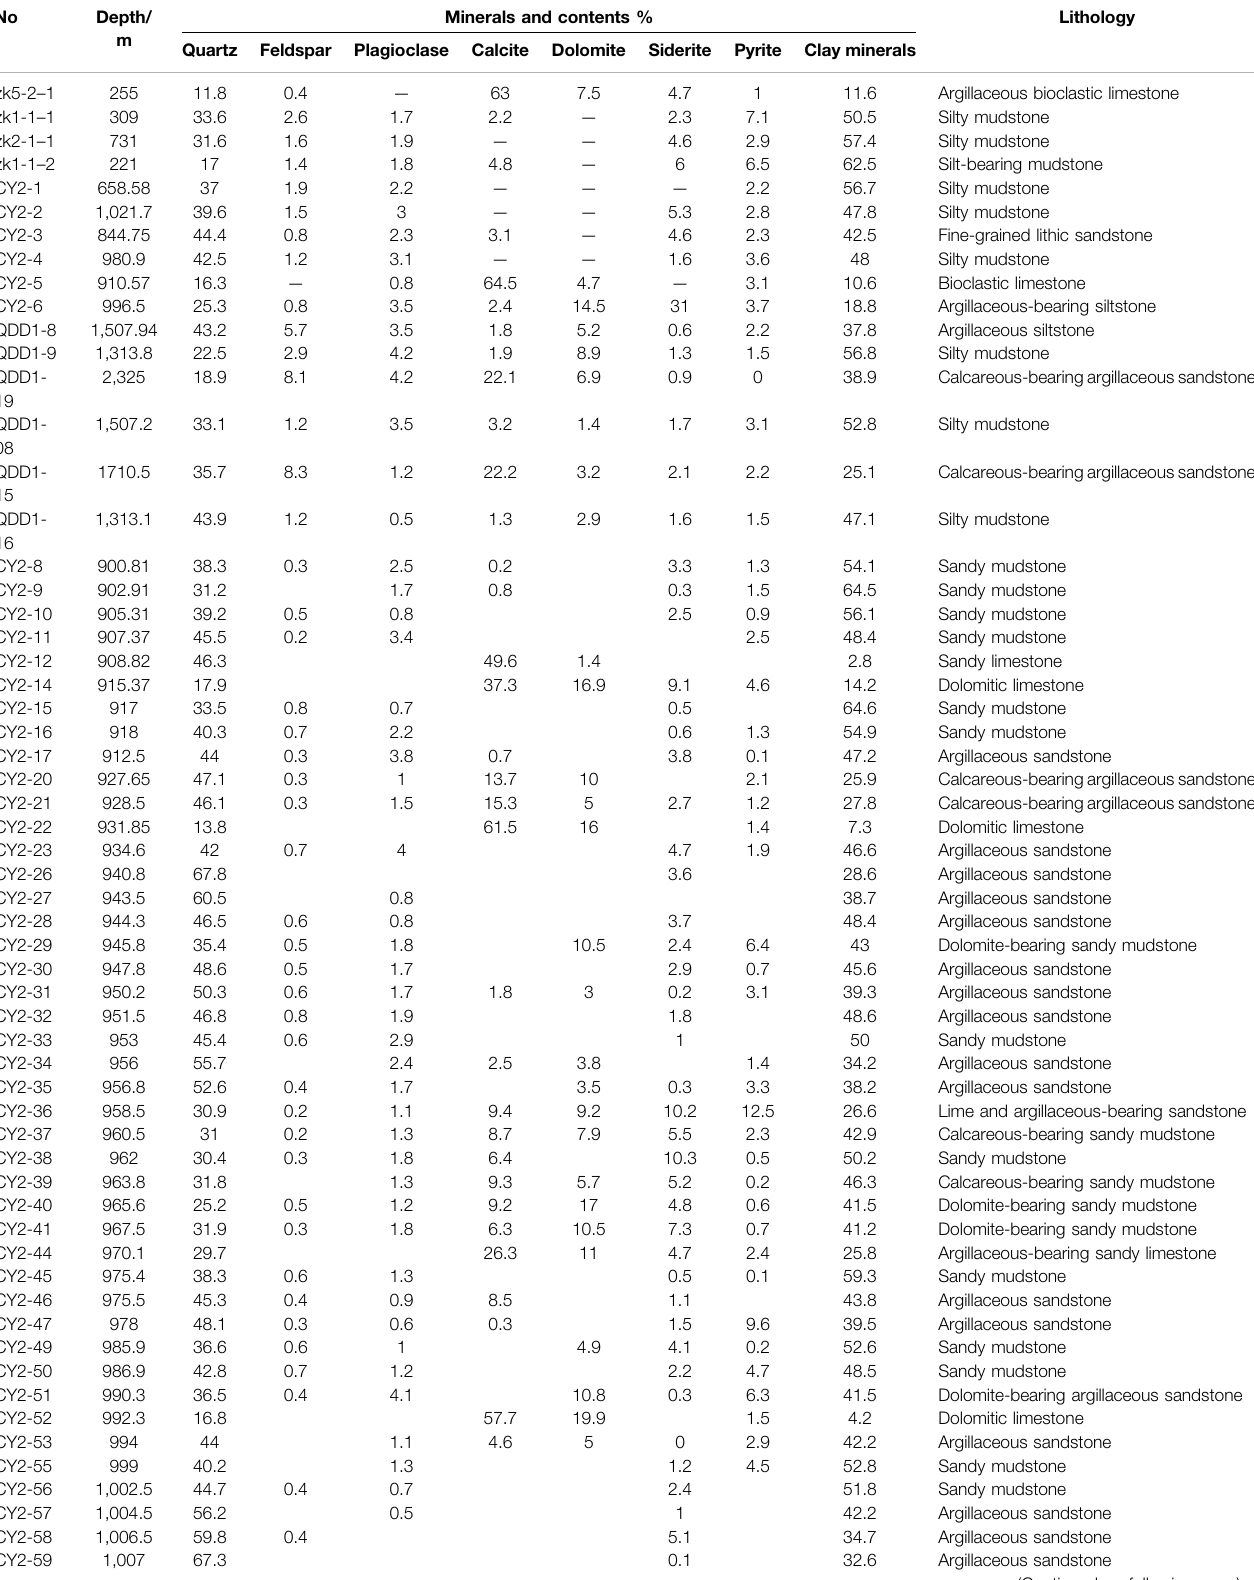
TABLE 1 | XRD analysis-based mineral compositions of fi ne-grained transitional deposits of the Upper Carboniferous Keluke Formation. No Depth/